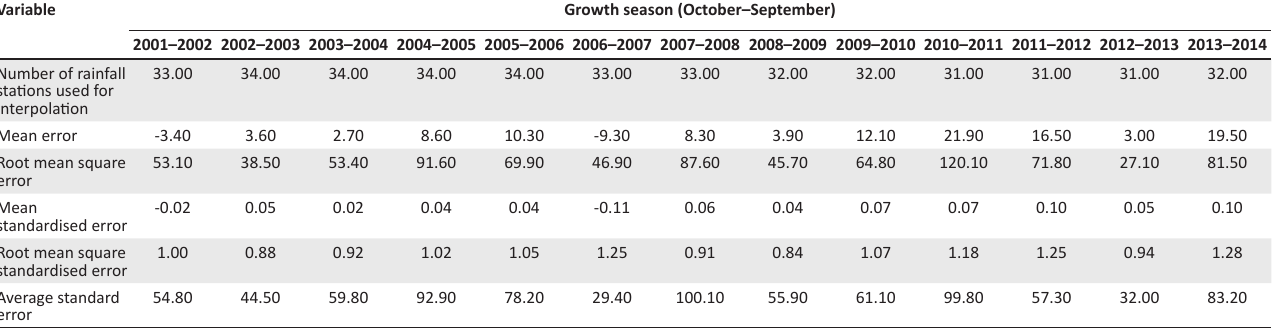
Producer’s accuracy ( %